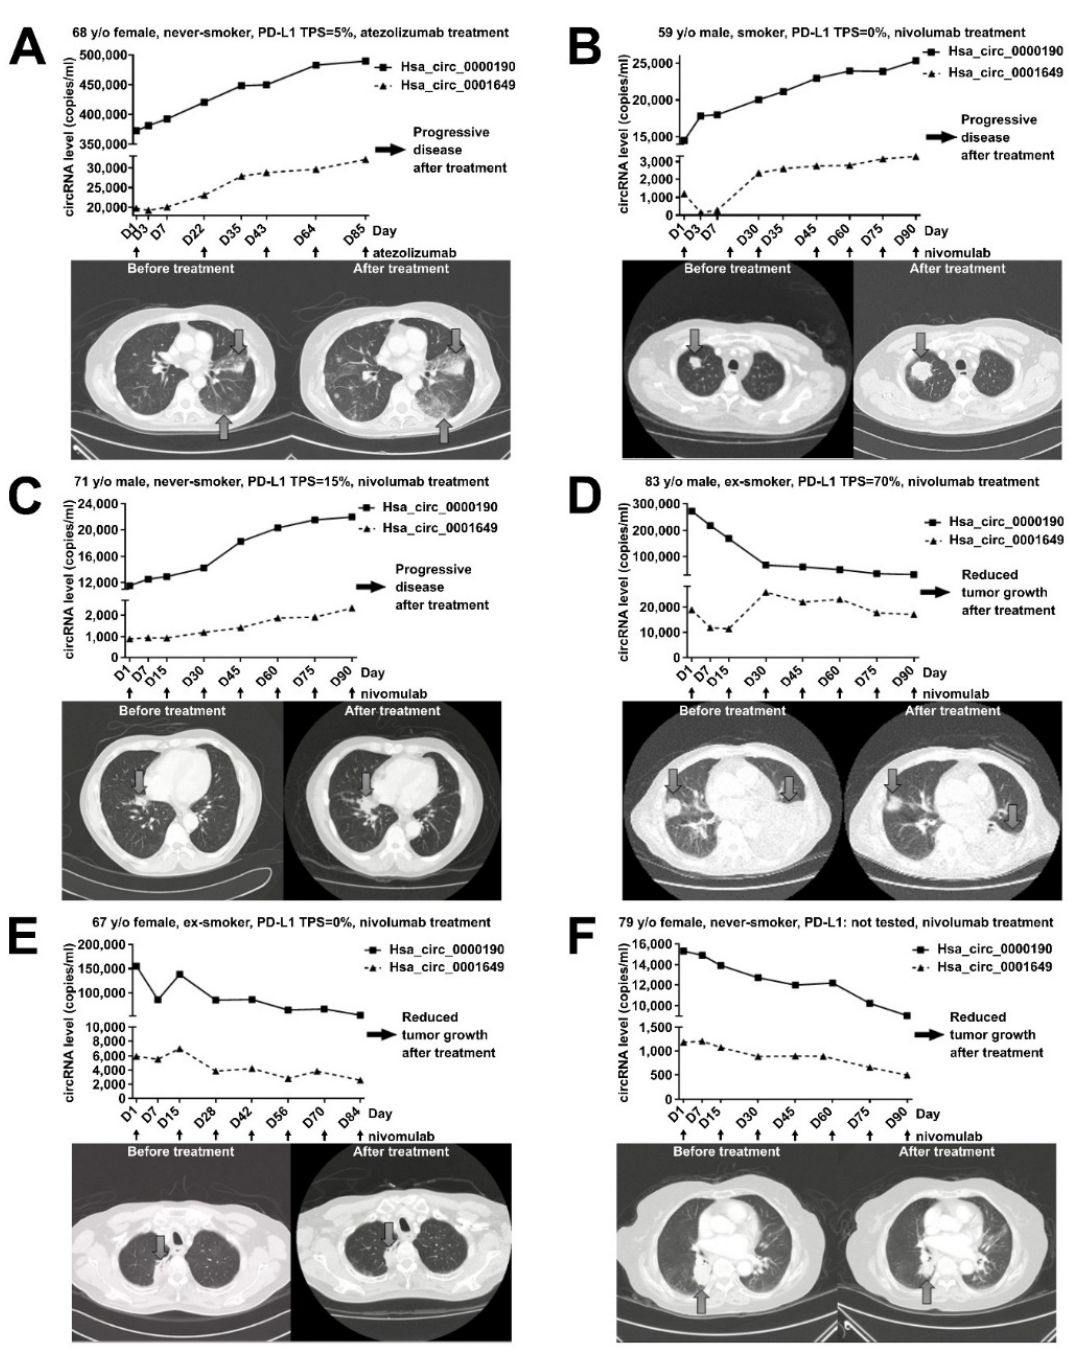
Figure 6. Monitoring the treatment response by plasma levels of circRNAs in lung cancer patients receiving immunotherapy. ( A – F ) RT-ddPCR analysis of expression of plasma hsa_circ_0000190 and hsa_circ_0001649 (top panel) and chest CT scans before and after treatment (bottom panel) in six cases of LC patients receiving immunotherapy. Black arrows indicate the time points of drug administration (atezolizumab or nivomulab) in the treatment time course. Big gray arrows indicate tumors on the CT scans.